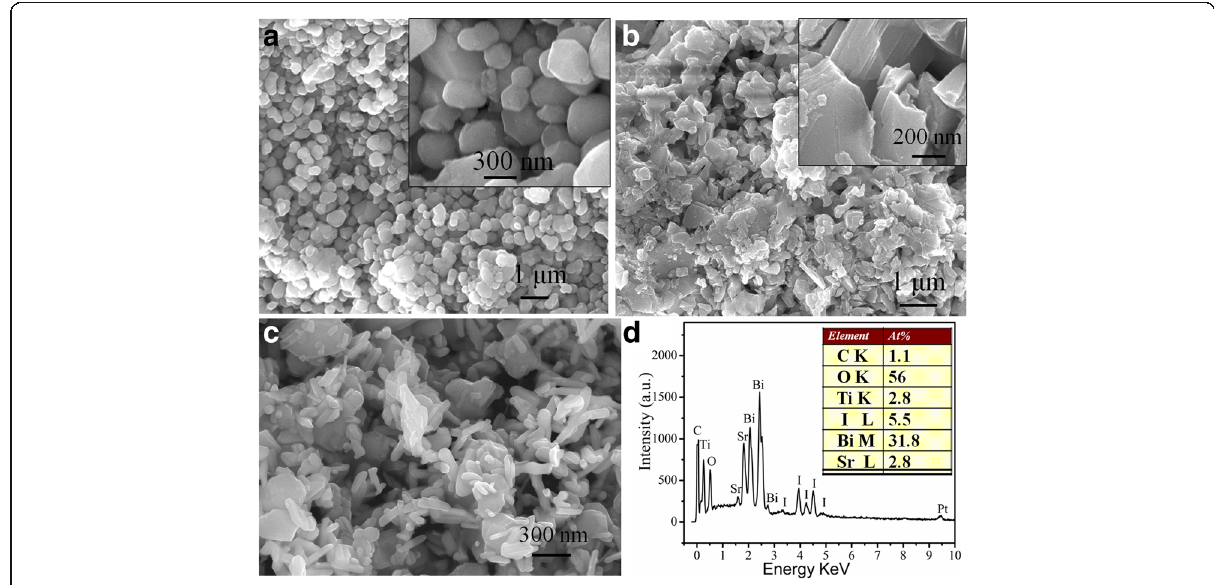
Fig. 3 SEM images of a pure SrTiO 3 , b pure Bi 5 O 7 I, c 30 wt% SrTiO 3 /Bi 5 O 7 I nanocomposite, and d EDS spectrum of 30 wt%